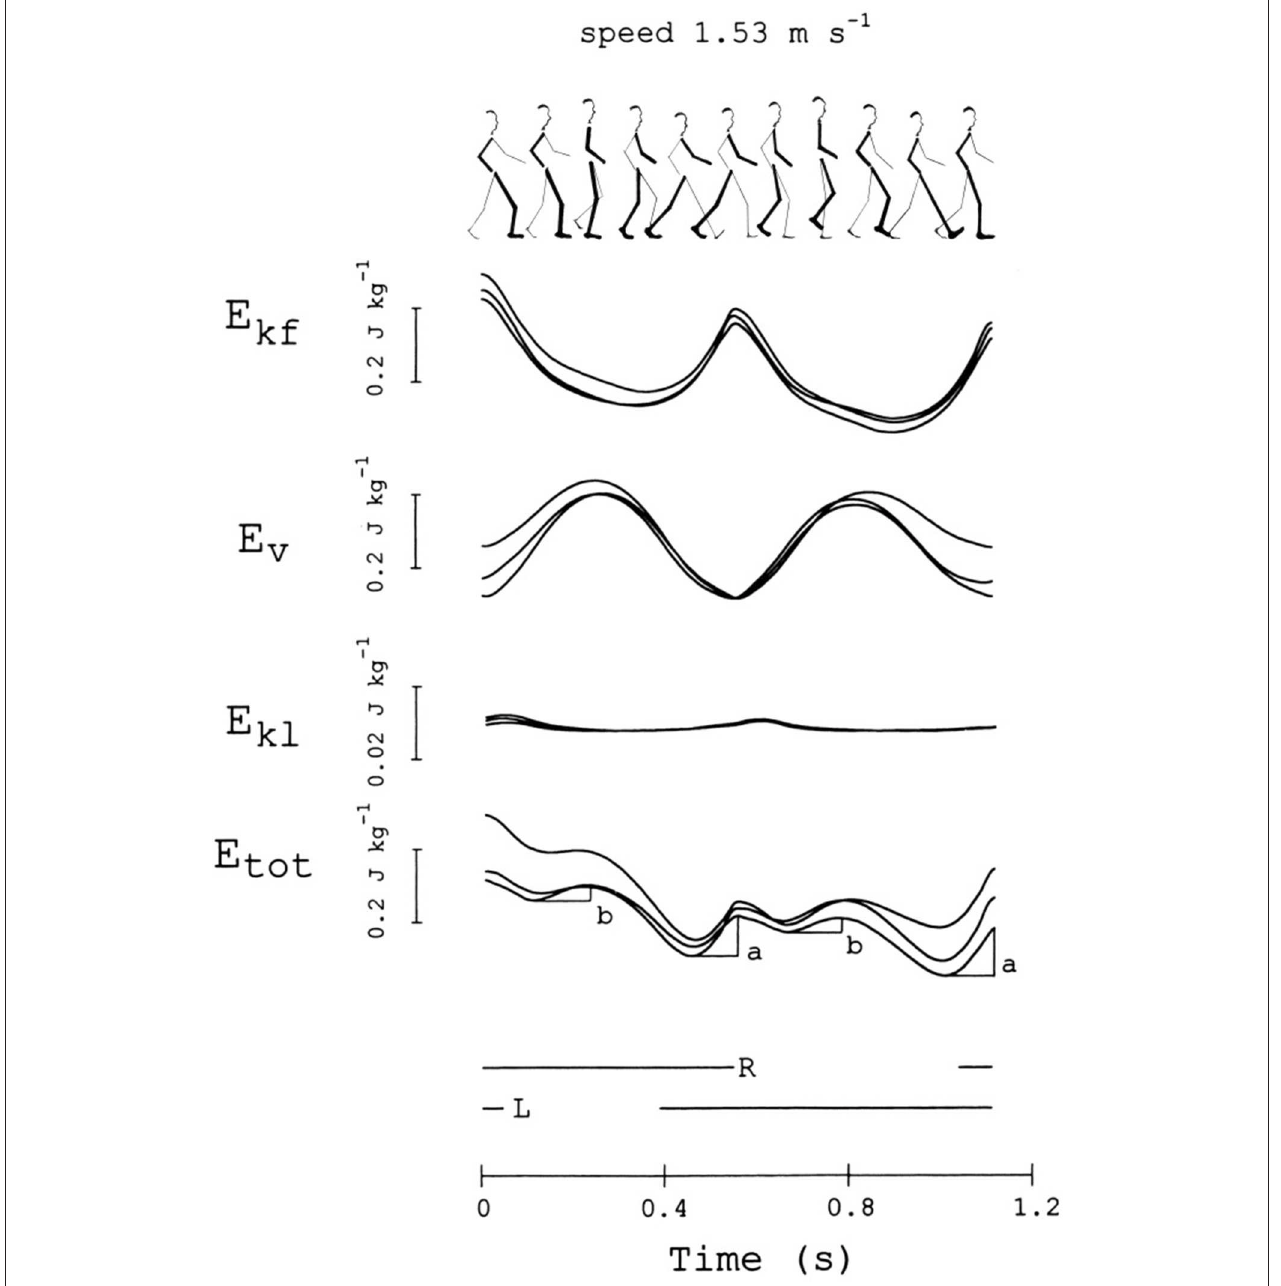
FIGURE 5 | Changes in mechanical energy of the center of mass (CoM) during one stride. This subject (sketched on top) was a woman, 36 years of age, 1.5m in height, 50kg in weight, walking at 1.53m s − 1 . From top to bottom, the curves refer to the mechanical energy changes of the CoM due to motion in the forward, vertical and lateral directions (E kf , E v , and E kl , respectively), and their sum, E tot = E kf + E v + E kl (note the scale difference for E kl ). The stride is considered to begin when E kf reaches a maximum. Curves from three different strides, performed at about the same average speed ( ± 10%), are superimposed. The bottom horizontal lines mark the time intervals in which the right or the left foot is on ground. The a and b labels indicate the increments of E tot , necessarily sustained by positive muscle work (external work, W ext ). Adapted from Tesio et al. (20), used with permission.